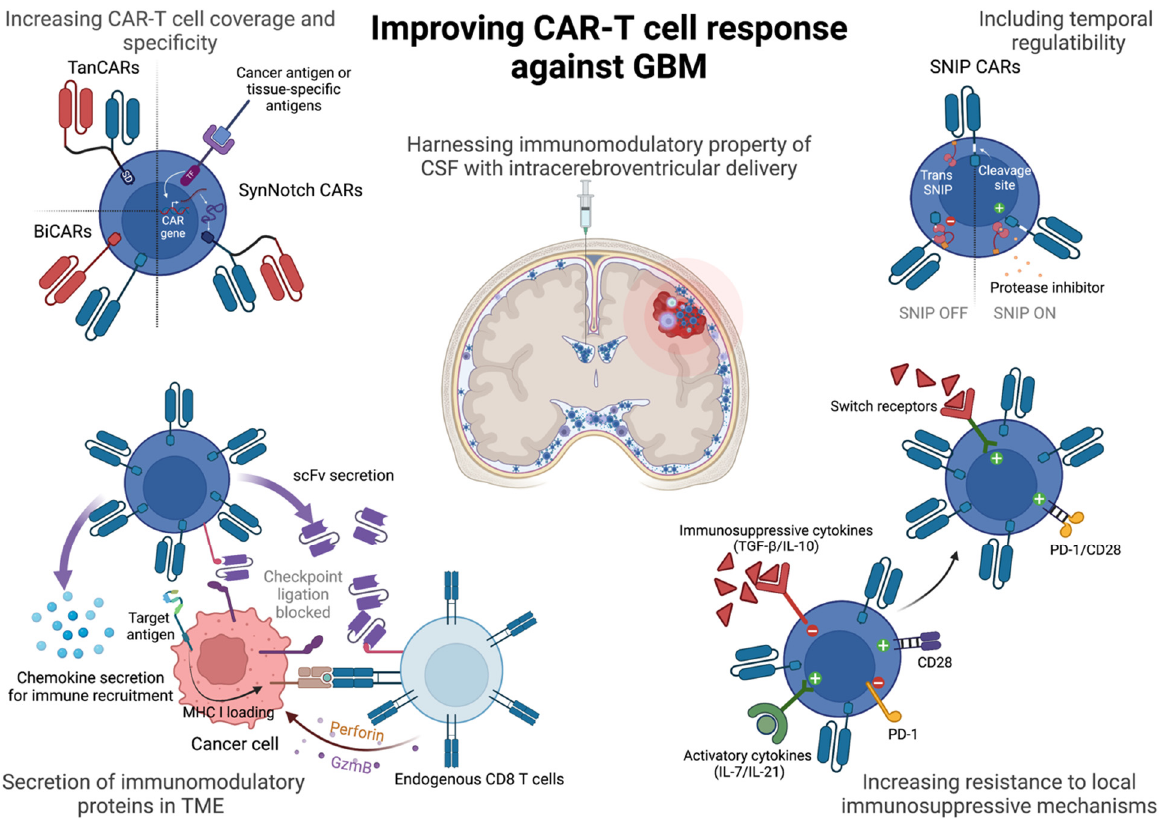
Figure 1. Strategies to improve CAR-T cells against GBM. CAR-T cells can be improved by adding greater antigen coverage against GBM, engineering tunability of response, resistance to exhaustion and immunosuppressive cytokines in the GBM tumor microenvironment. Intracerebroventricular route of administration of CAR-T cells might further licence CAR-T cells for long-term persistence and memory phenotype. SD = signaling domain comprising CD3 ζ and co-stimulatory domains of CD28, ICOS, 4-1BB or OX-40. TF = transcription factor. scFv = single chain variable fragment. GzmB = granzyme B. TGF- 𝛽 = transforming growth factor- 𝛽. PD-1 = programmed death-1. Created with